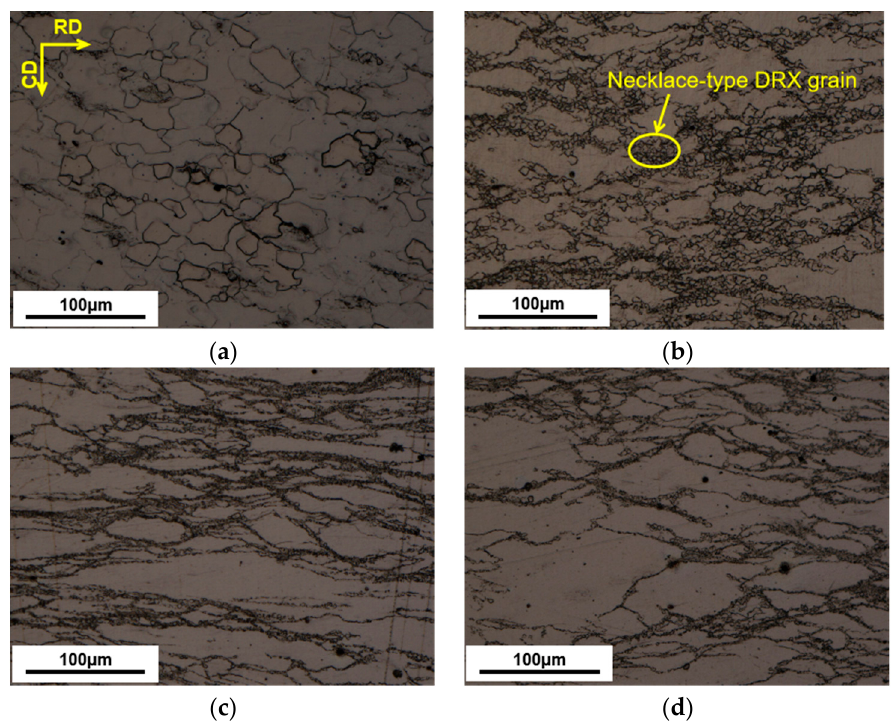
Figure 5. The samples’ microstructure with di ff erent strain rates at 673 K. ( a ) 0.001 s − 1 , ( b ) 0.01 s − 1 , ( c ) 0.1 s − 1 , ( d ) 1 s − 1 . ( c ) 0.1 s − 1 , ( d ) 1 s − 1